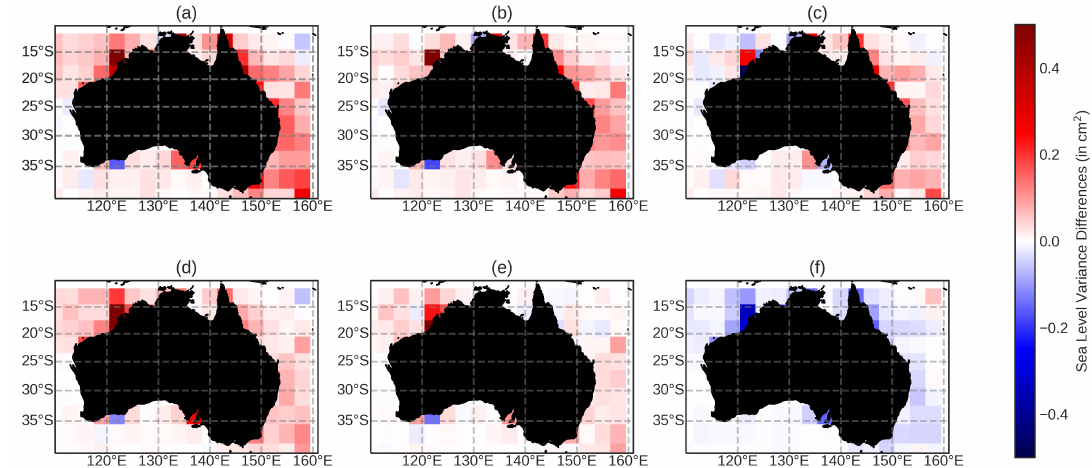
Figure 5. The sea-level variance differences between the scenarios presented for the Jason-2 altimeter in the Australia region. The subplots of sea-level variance differences are as follows: ( a ) modTiME–EOT-R; ( b ) modTiME–EOT-I; ( c ) modTiME– modFES; ( d ) modFES–EOT-R; ( e ) modFES–EOT-I; and ( f ) EOT-R–EOT-I. The figures are designed so that when the colours are blue, the first model has a lower variance, while when the regions are red, the first model has a higher variance compared to the second